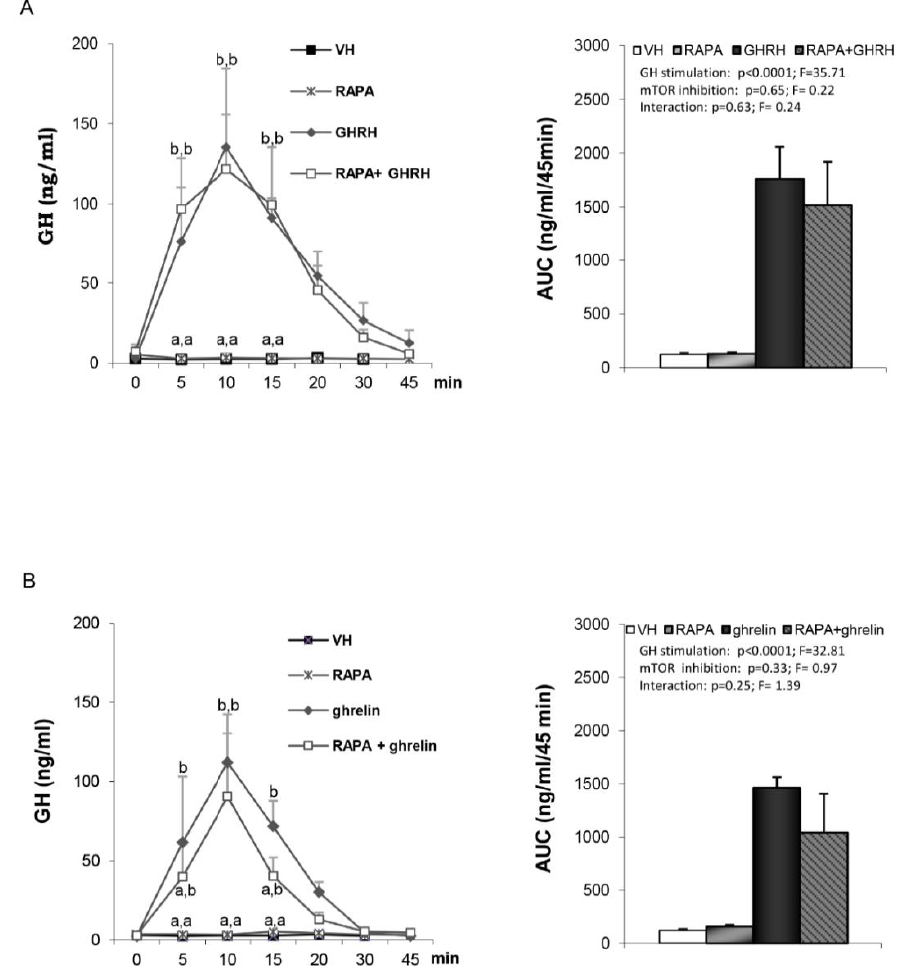
Figure 4. Serum GH profile and area under the curve (AUC) over the study period (45 min) after administration of: Panel ( A ) VH (5 µL DMSO icv plus 200 µL saline iv), RAPA (50 µg rapamycin icv